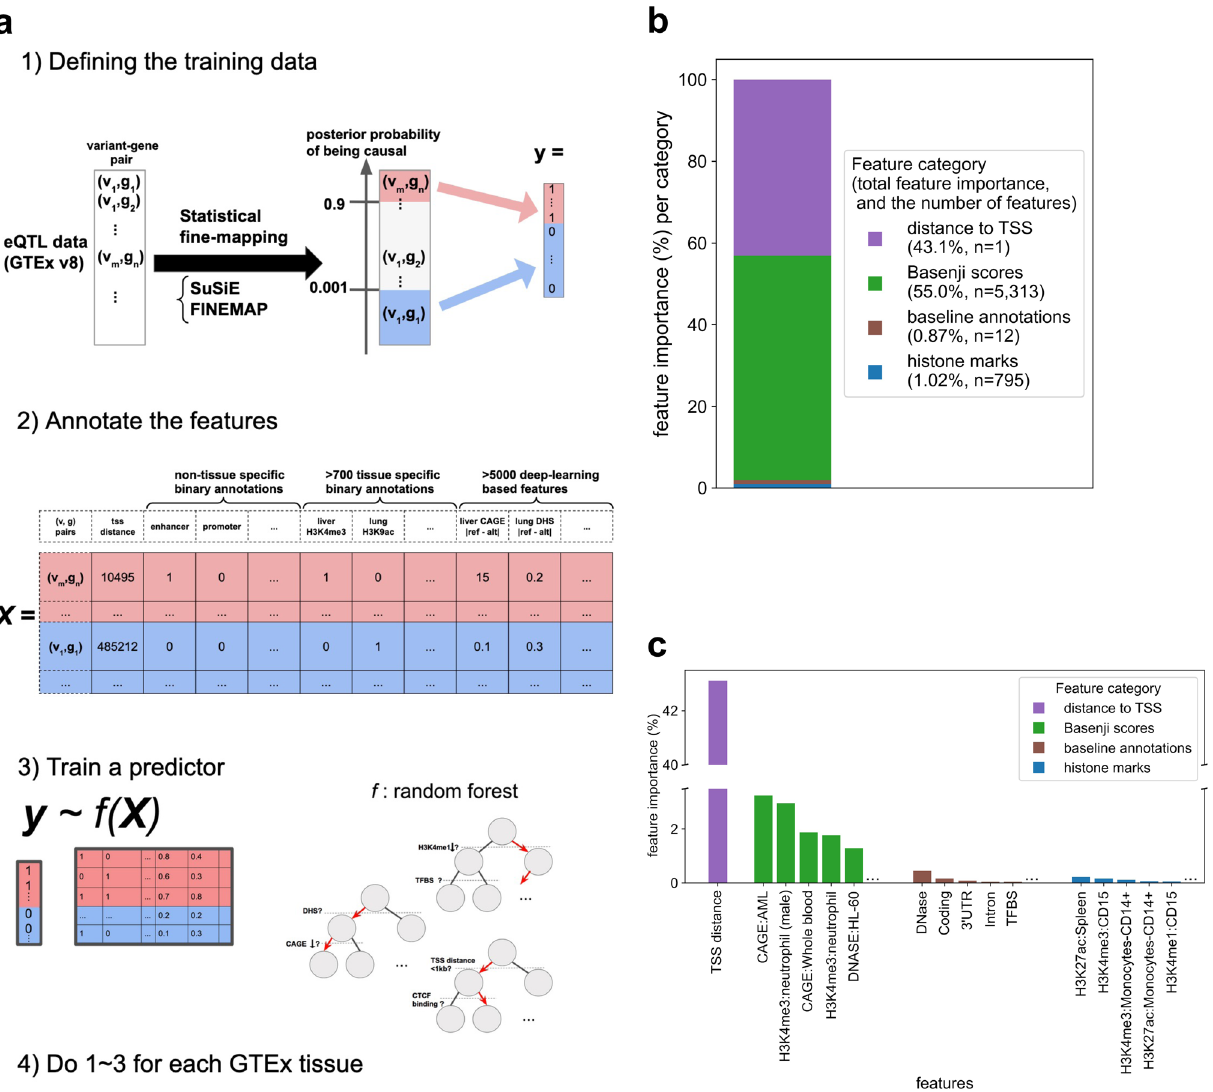
Fig. 2 Schematic overview and feature importance of the expression modi fi er score (EMS). a EMS is built by (1) de fi ning the training data based on fi ne- mapping of GTEx v8 data, (2) annotating the variant – gene pairs with functional features, and (3) training a random forest classi fi er. We do this for each tissue. b , c Feature importance (mean decrease of impurity MDI 59 ) for four different feature categories ( b ), and top features for each category ( c ). Baseline annotations are non-tissue-speci fi c binary annotations from Finucane et al. 6 , and histone marks are tissue-speci fi c binary histone mark annotations from Roadmap 5 . In b , n is the number of features in the